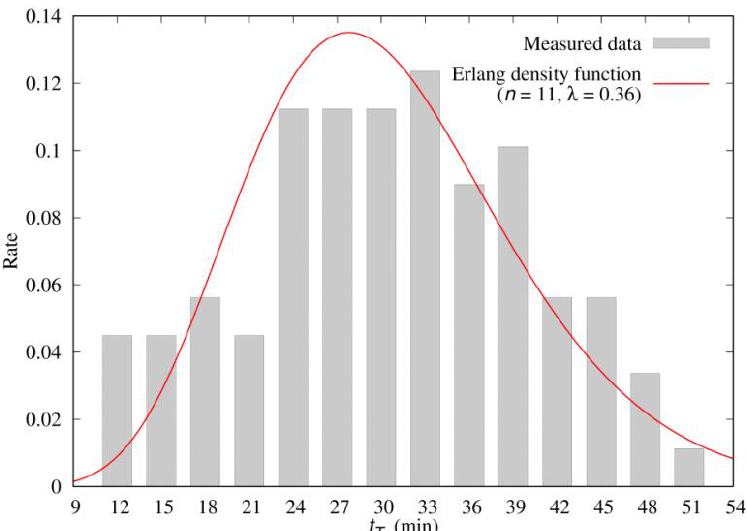
Figure 11. The histograms for t T.